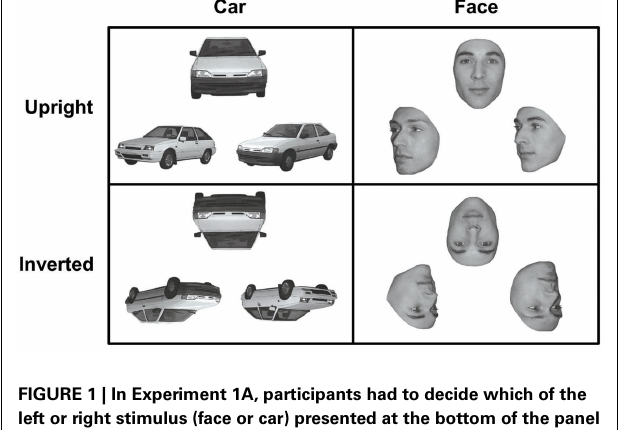
Table 1 | Characteristics of the deaf sample.